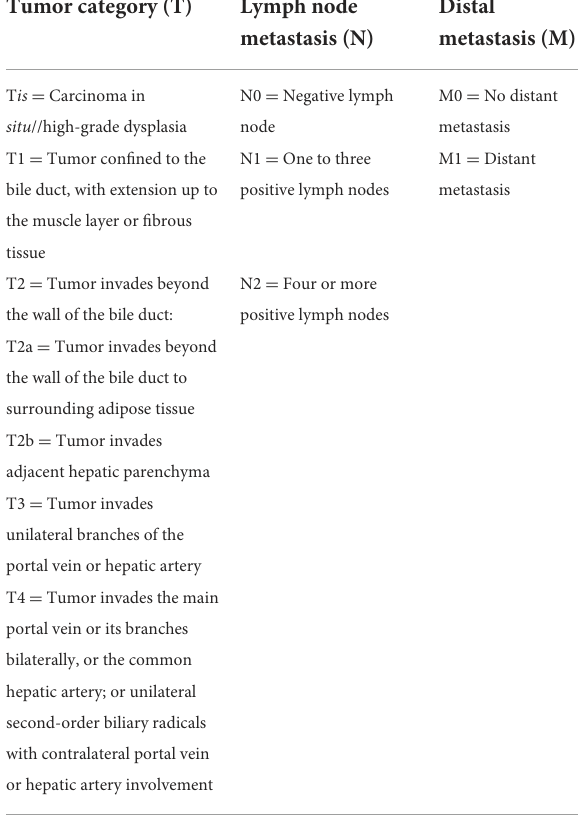
TABLE 1 Definition of TNM categories of the eighth AJCC/UICC staging